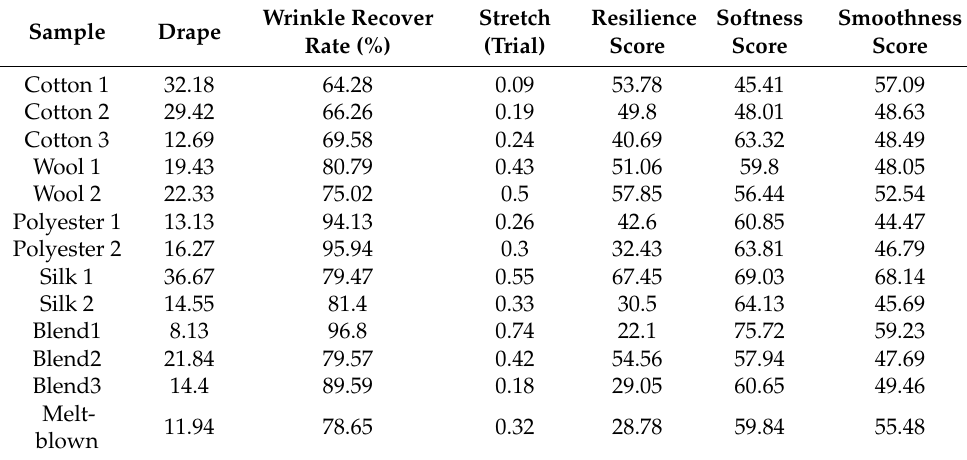
Table 2. Fabric handle assessment parameters of